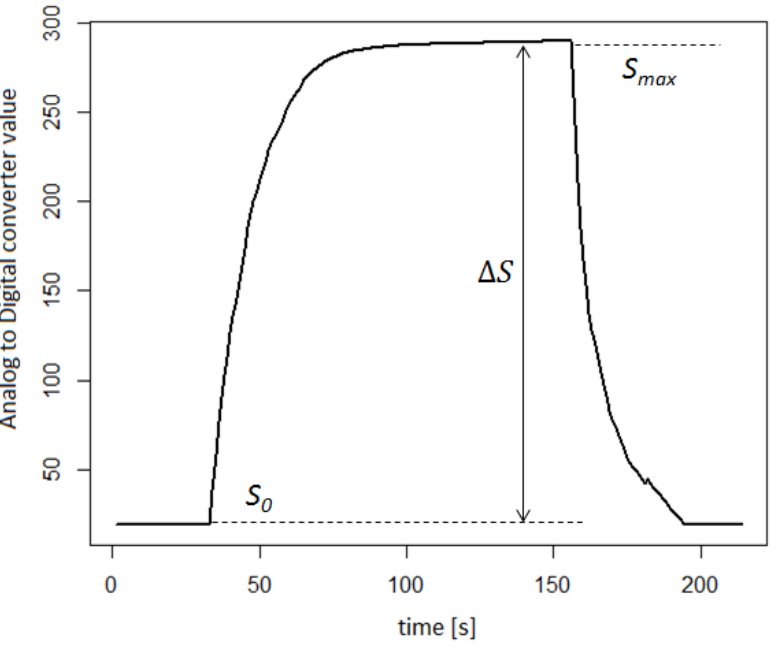
Figure 3. Example of the TGS2602 sensor response with marked signal parameters used in further data